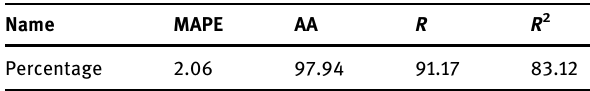
Table 3: Coe ffi cients of regression